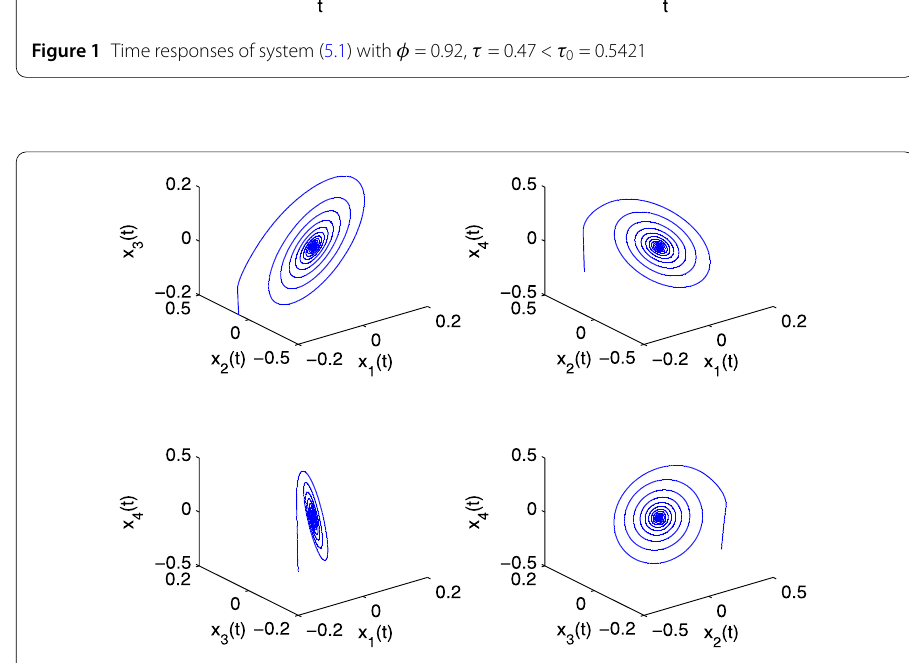
Figure 2 Phase diagrams of system (5.1) with φ = 0.92, τ = 0.47 < τ 0 = 0.5421